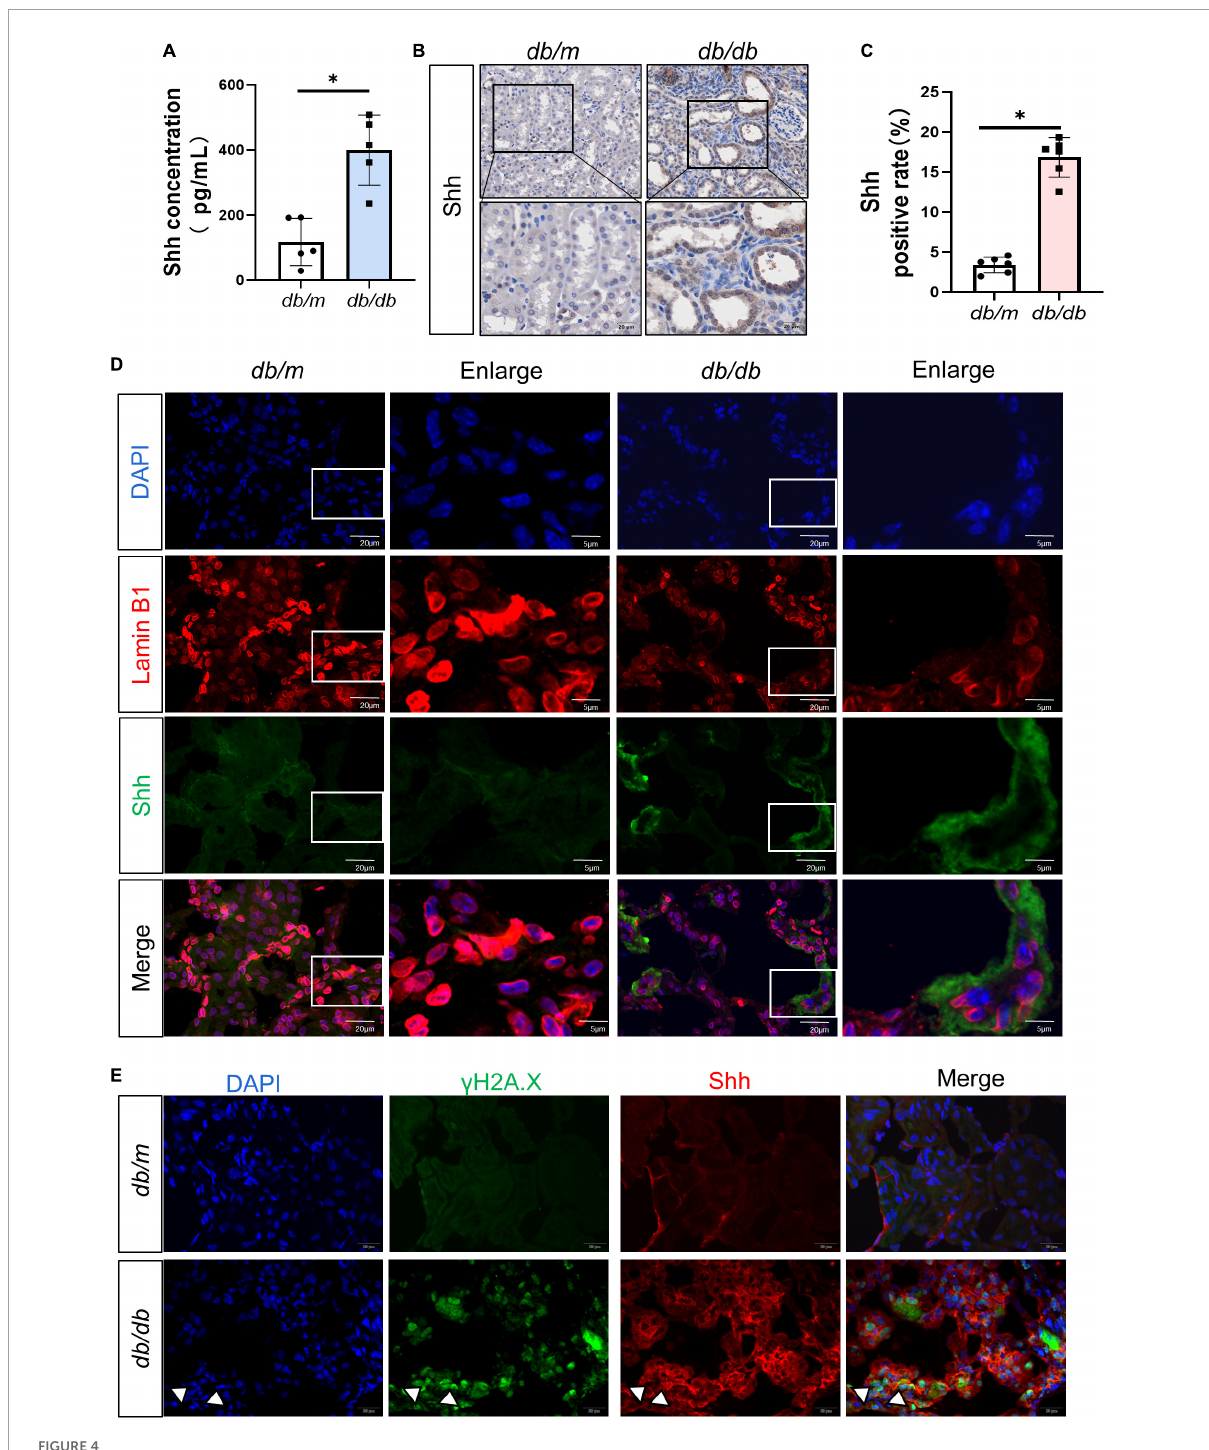
FIGURE4 Expression and distribution of Sonic hedgehog (Shh) in the process of diabetic kidney disease (DKD). (A) The content of Shh in renal tissue was detected by enzyme-linked immunosorbent assay (ELISA). (B,C) Representative micrographs show immunohistochemical staining of Shh in different groups (B) and quantitative analysis (C) of Shh. (D) Representative micrographs showed immunofluorescence staining of Lamin B1 and Shh in different groups. DAPI staining (blue) represents cell nucleus, Bar = 20 µ m. The enlarge images indicate the co-expression of positive staining cells. Bar = 5 µ m. (E) Representative micrographs showed immunofluorescence staining of γ H2A.X and Shh in different groups. White arrows indicate the co-expression of positive staining cells. DAPI staining (blue) represents cell nucleus, Bar = 20 µ m. All data are presented as mean ± standard deviation (SD) from three independent experiments. n = 5; ∗ P < 0.05 vs. db/m